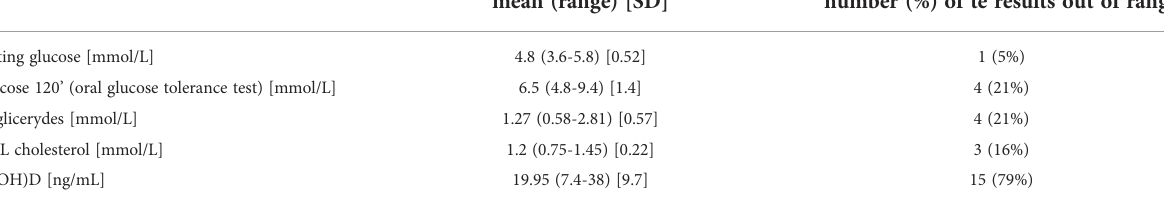
TABLE 1 Characteristic of the study